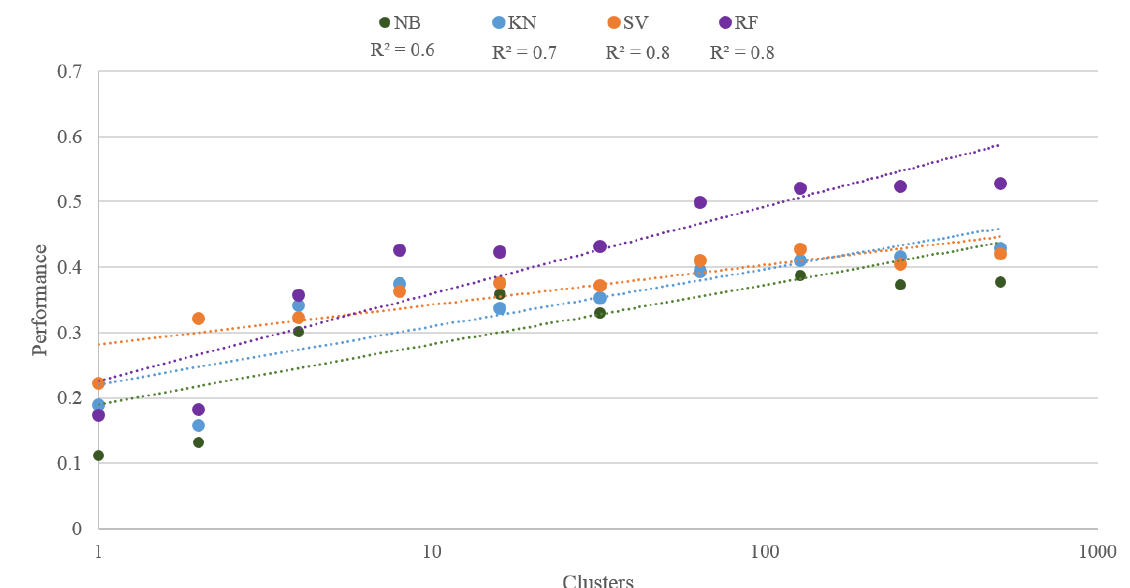
Figure 5. Overall performance (percentage of correctly identified pixels) for each MLA for an increasing number of